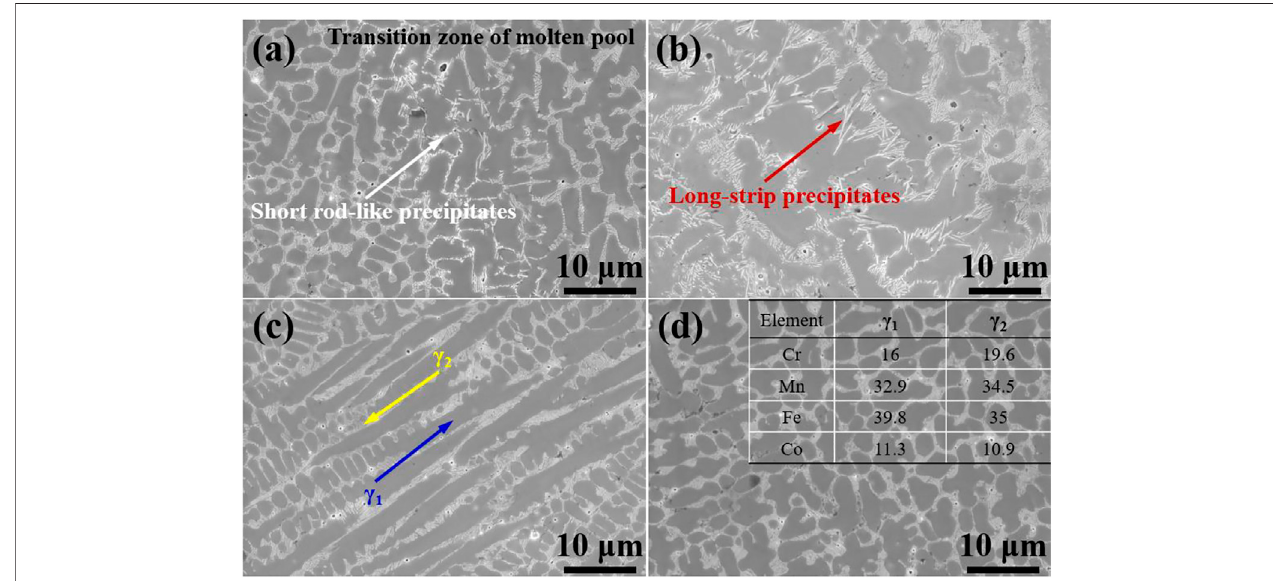
FIGURE 5 | Microstructure and elemental composition of the 10 – 0 sample. (A – D) are only different microstructure of local region in the the 10-0 sample. .